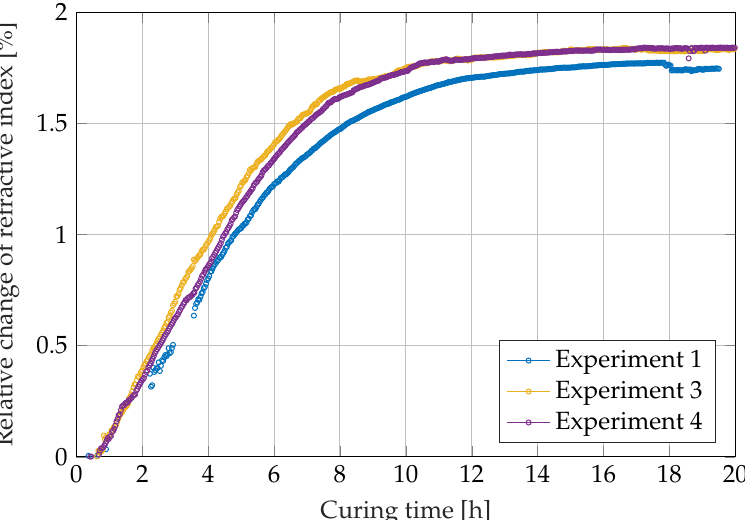
Figure 8. Relative changes in the refractive index during the curing reaction of RIMR 426 resin with RIMH 435 curing agent calculated from the light dot